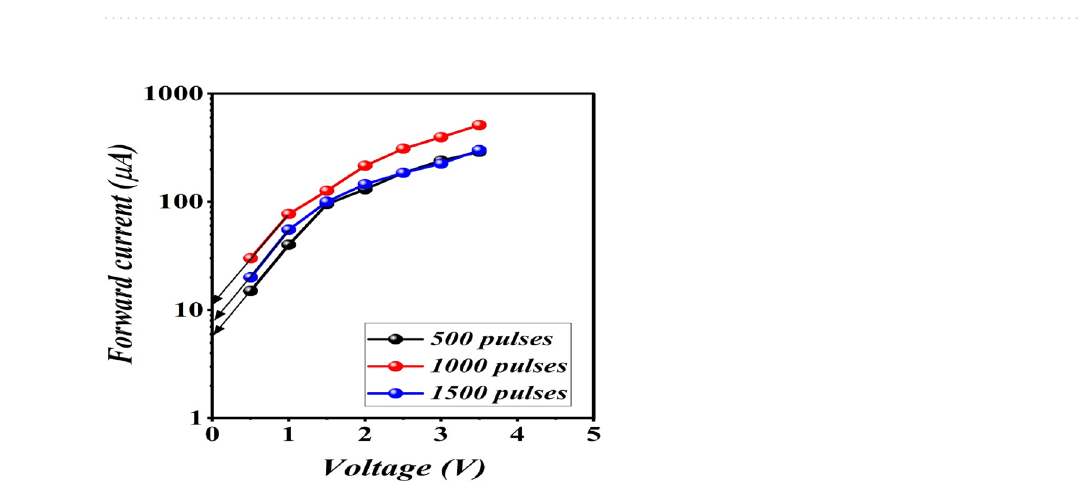
Figure 12. Dark I–V characteristic of isotype B 4 C/Si heterojunction under forward and reverse bias prepared at different number of laser pulses.